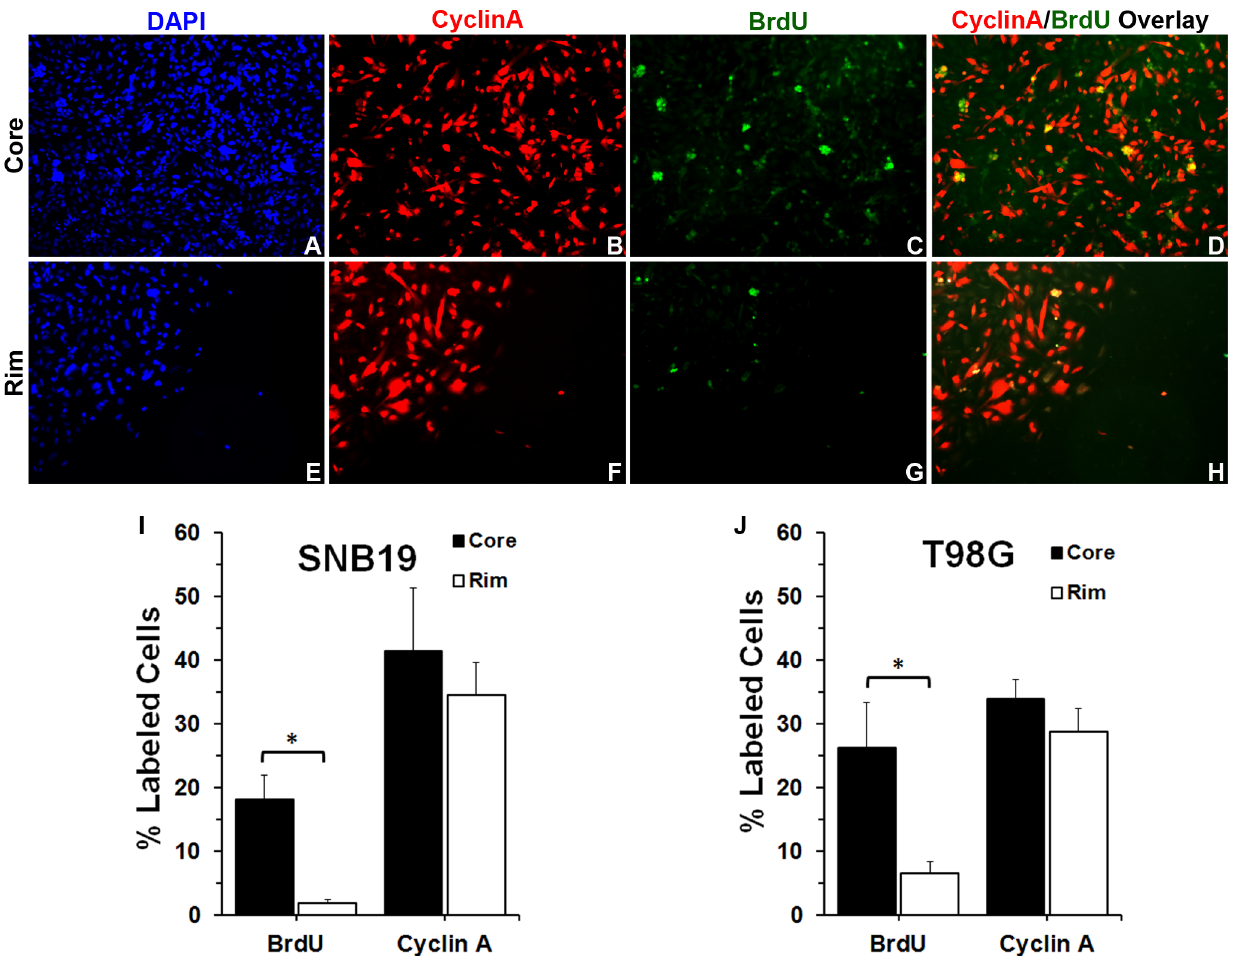
Figure 3. Glioma cells seeded in a way that manifests cell crowding and cell dispersion show that at the core cells were more proliferative than glioma cells located at the rim. (A) SNB19 cells at the core of the cell circle stained for DAPI to account for all cells. (B) Same image field as panel A at the core of the cell circle but stained for Cyclin A (Cy3-red), (C) incorporated BrdU (FITC-green), and (D) showing CyclinA (Cy3-Red) - BrdU (FITC-green) Overlay. (E) SNB19 cells at the rim of the cell circle stained for DAPI to account for all cells. (F) Same image field as panel E but stained for Cyclin A (Cy3-red), (G) incorporated BrdU (FITC-green), and (H) showing CyclinA (Cy3-Red) - BrdU (FITC-green) Overlay. (I) and (J) Quantitative analysis of Cyclin A- and BrdU-labeled SNB19 and T98G glioma cell numbers (n=3). The percent of Cyclin A-, and BrdU-labeled cells, and the total number of cells were measured. Statistical analysis was performed using a student T-test. * p , 0.05.